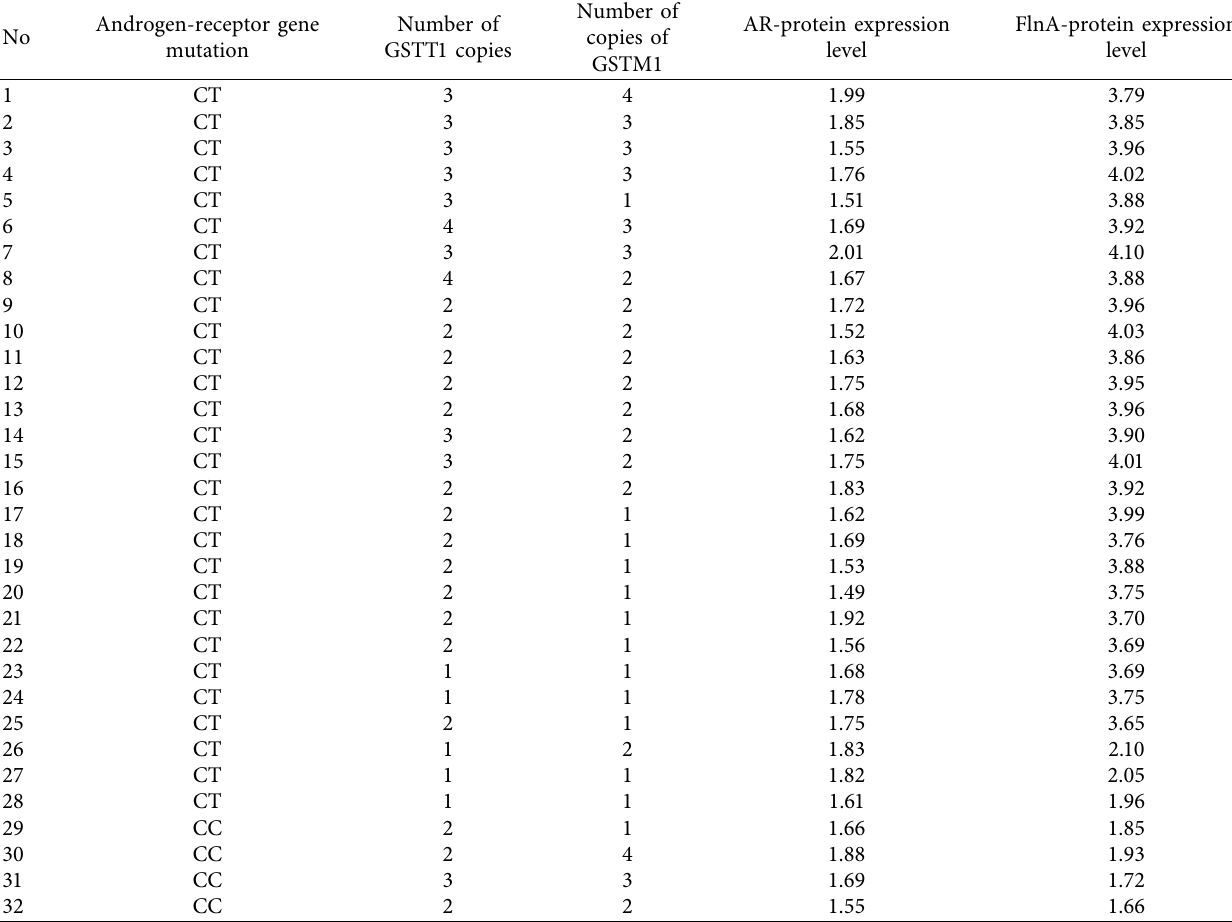
Table 7: Gene matrix of the prostate cancer group and normal control group.